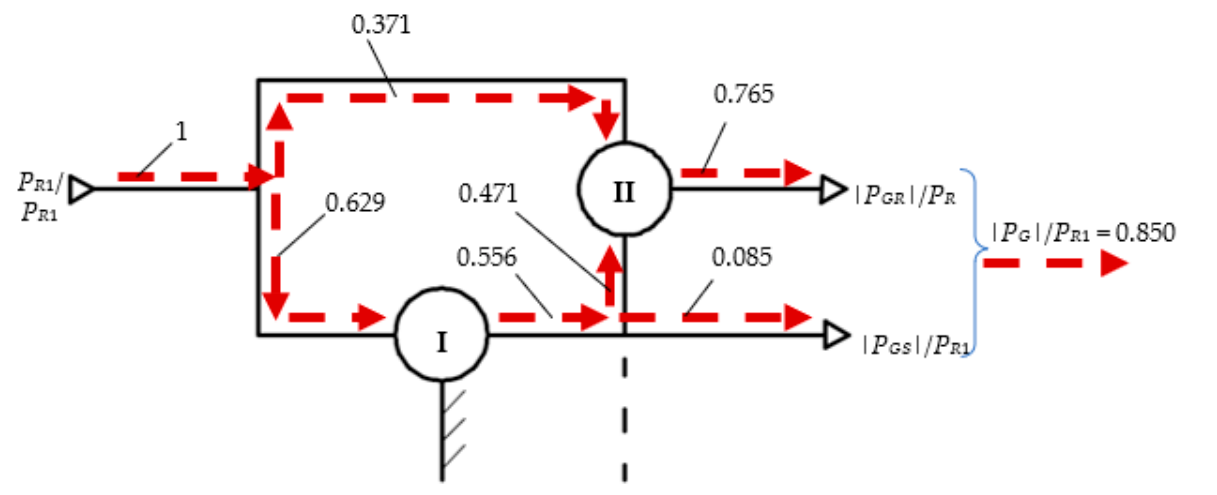
Figure 10. Reduced power flows of the 1-DOF and L = 3 system (Case D).